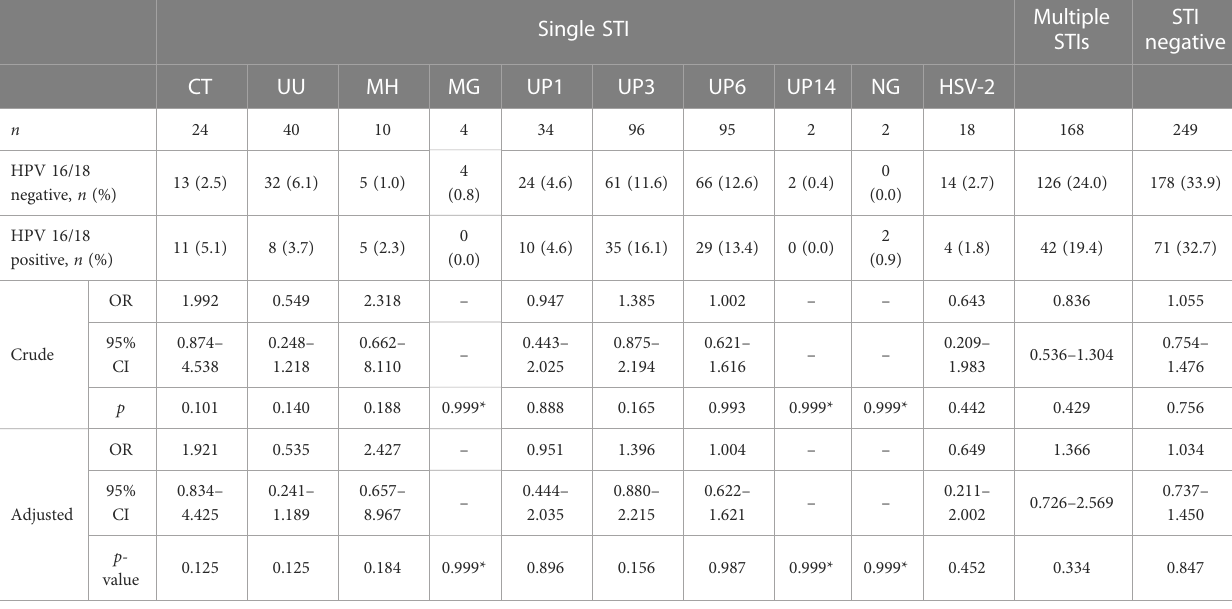
TABLE 3 Infection rates of STIs in groups with or without HPV 16/18 infection among HR-HPV-positive